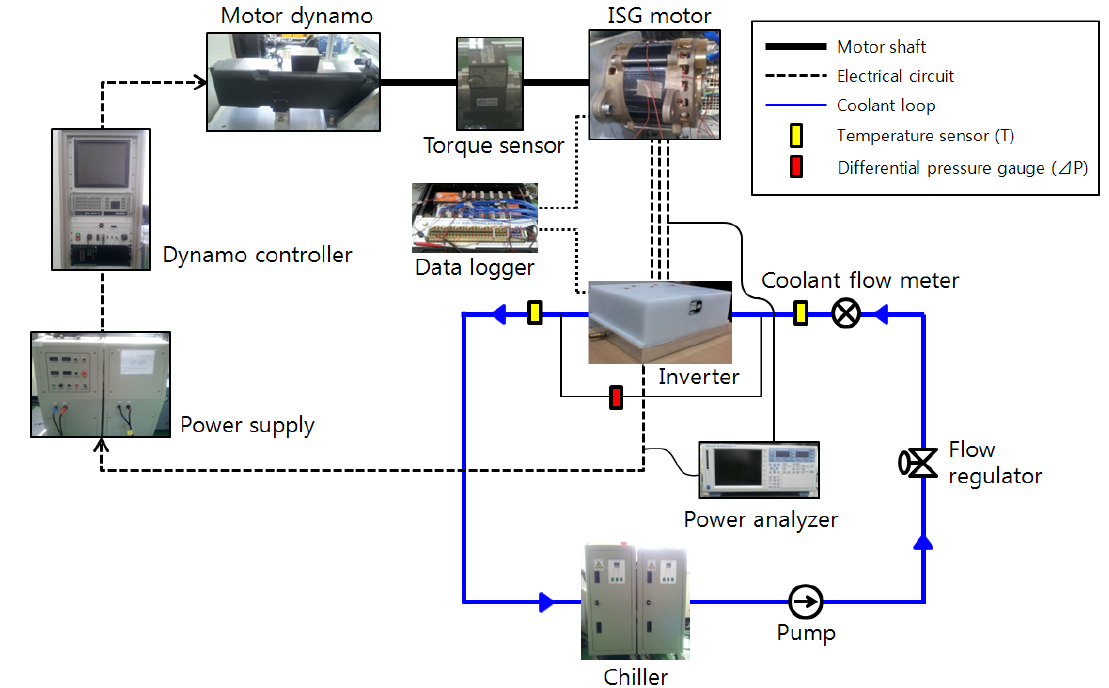
Figure 7. Experimental apparatus of ISG motor and